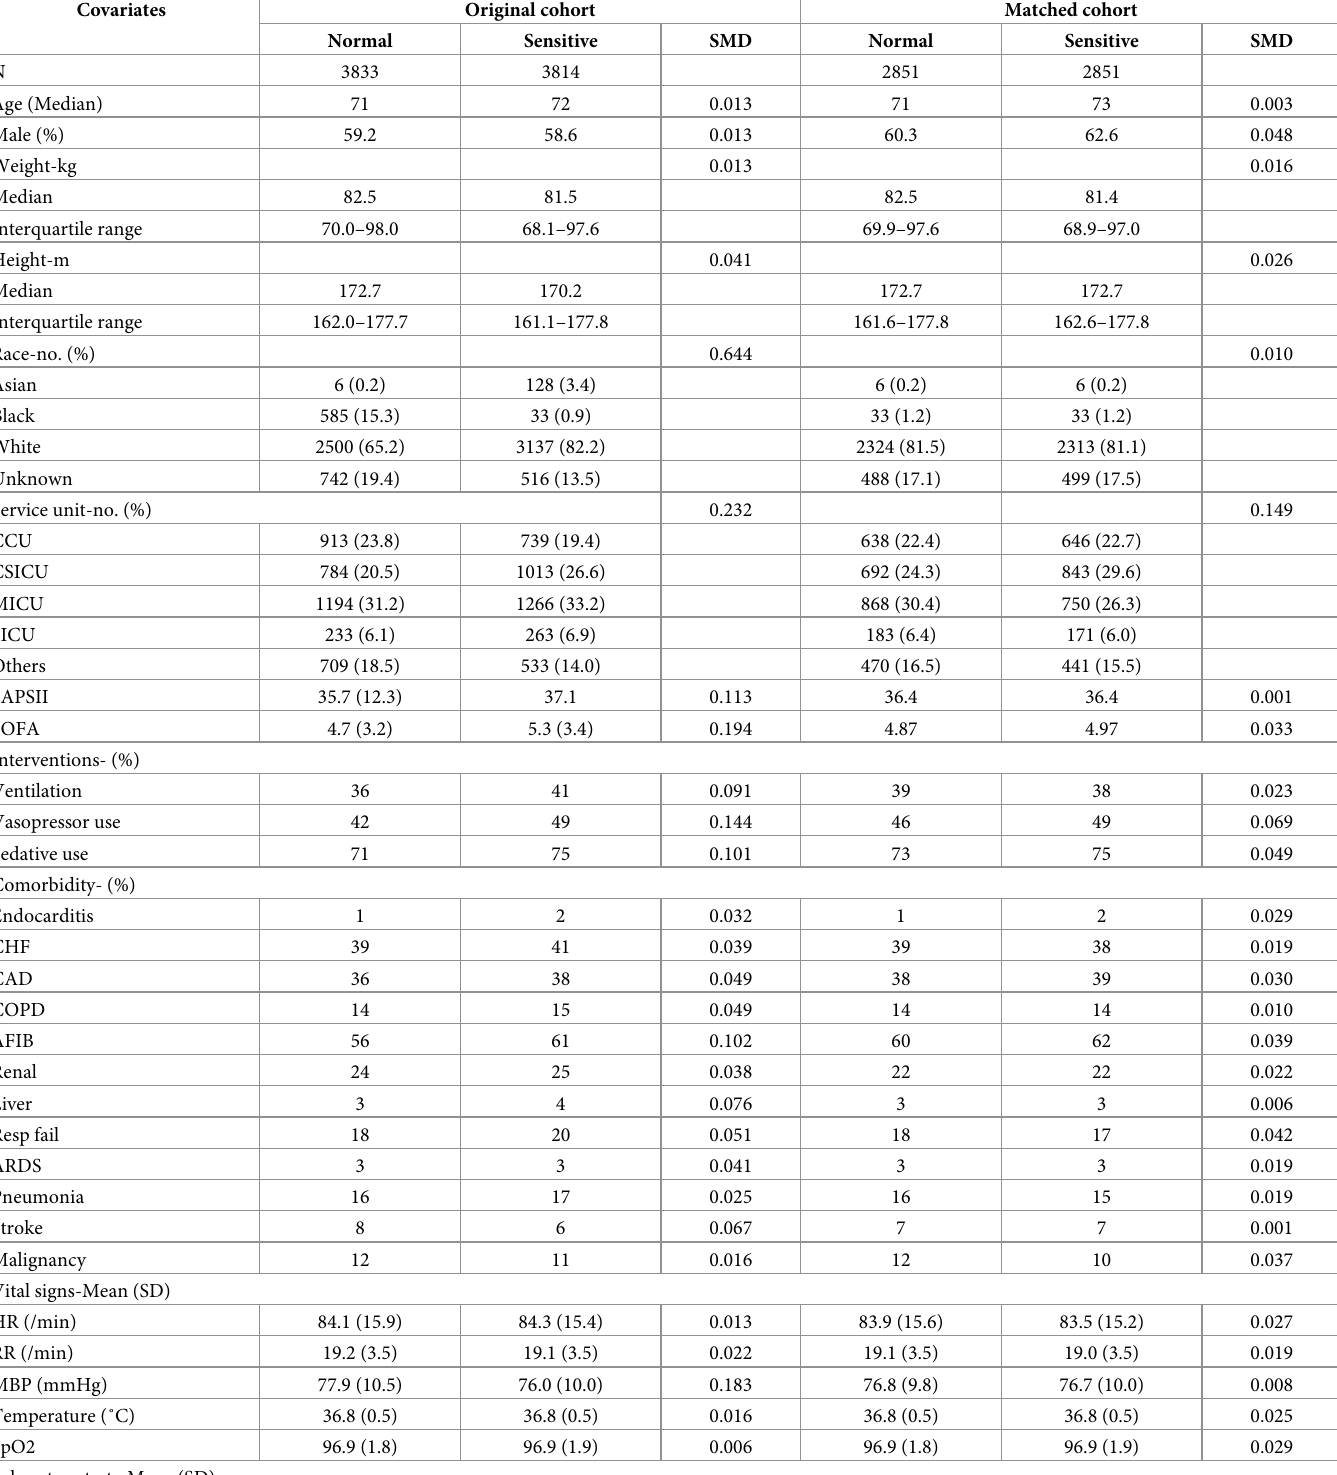
Table 1. Comparisons of demographic and clinical characteristics between the original cohort and matched